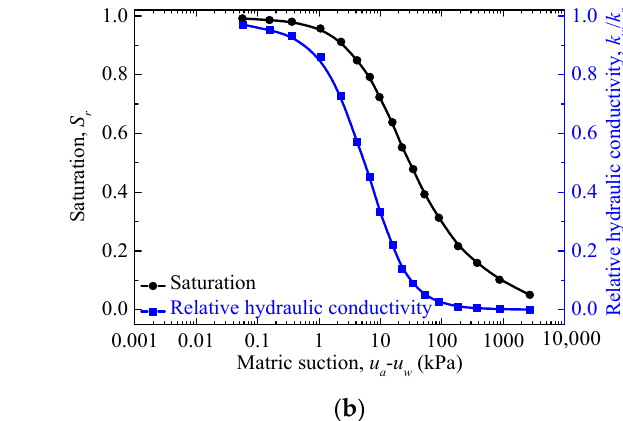
Figure 3. Soil water characteristic curve (SWCC) and relative hydraulic conductivity ( k w / k s ): ( a ) silty clay and ( b ) sandstone. Table 1. Geotechnical and hydromechanical properties of the soil